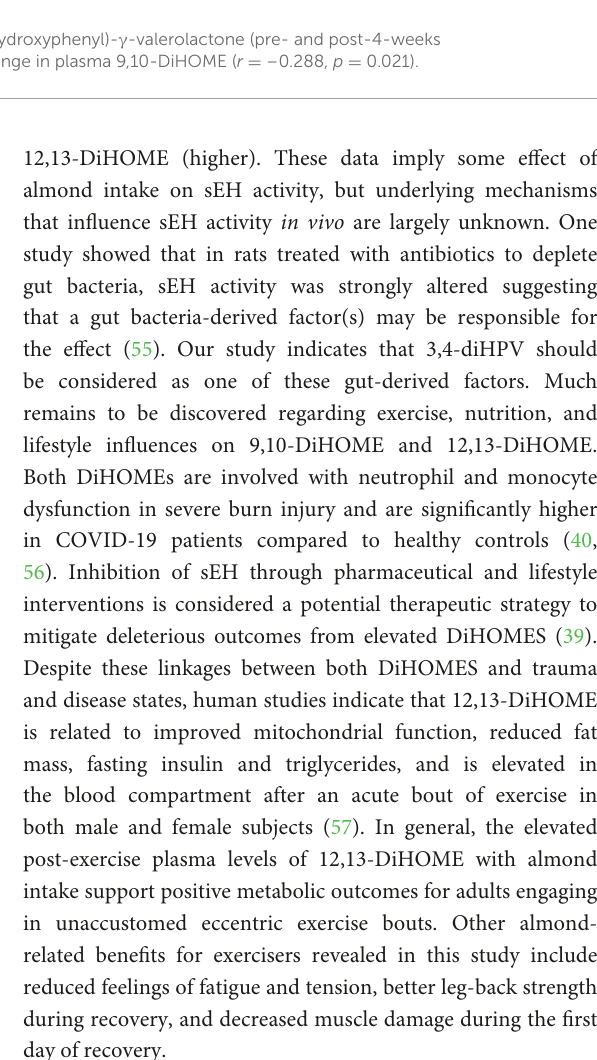
relationship was found between 5-(3 (cid:48) ,4 (cid:48) -dihydroxyphenyl)- γ